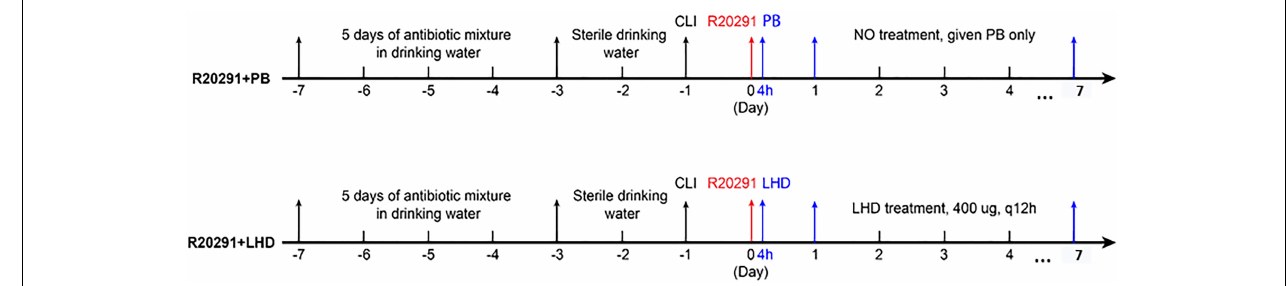
FIGURE 6 | Experimental scheme for evaluation of LHD treatment efficacy in mouse model of CDI. After 5 days of antibiotic pretreatment, mice were given autoclaved water for 2 days, followed by a single dose of clindamycin (10 mg/kg) intraperitoneally, 1 day before (day-1) challenge with C. difficile R20291 spores by gavage (day 0). The first group (R20291+PB) was infected with 10 6 C. difficile R20291 spores on day 0, and was given PBS (PB) by gavage at 4 h after spore gavage, followed by administration of PB by gavage twice a day from the first day (day 1) to the seventh day (day 7) after spore gavage. The second group (LHD +